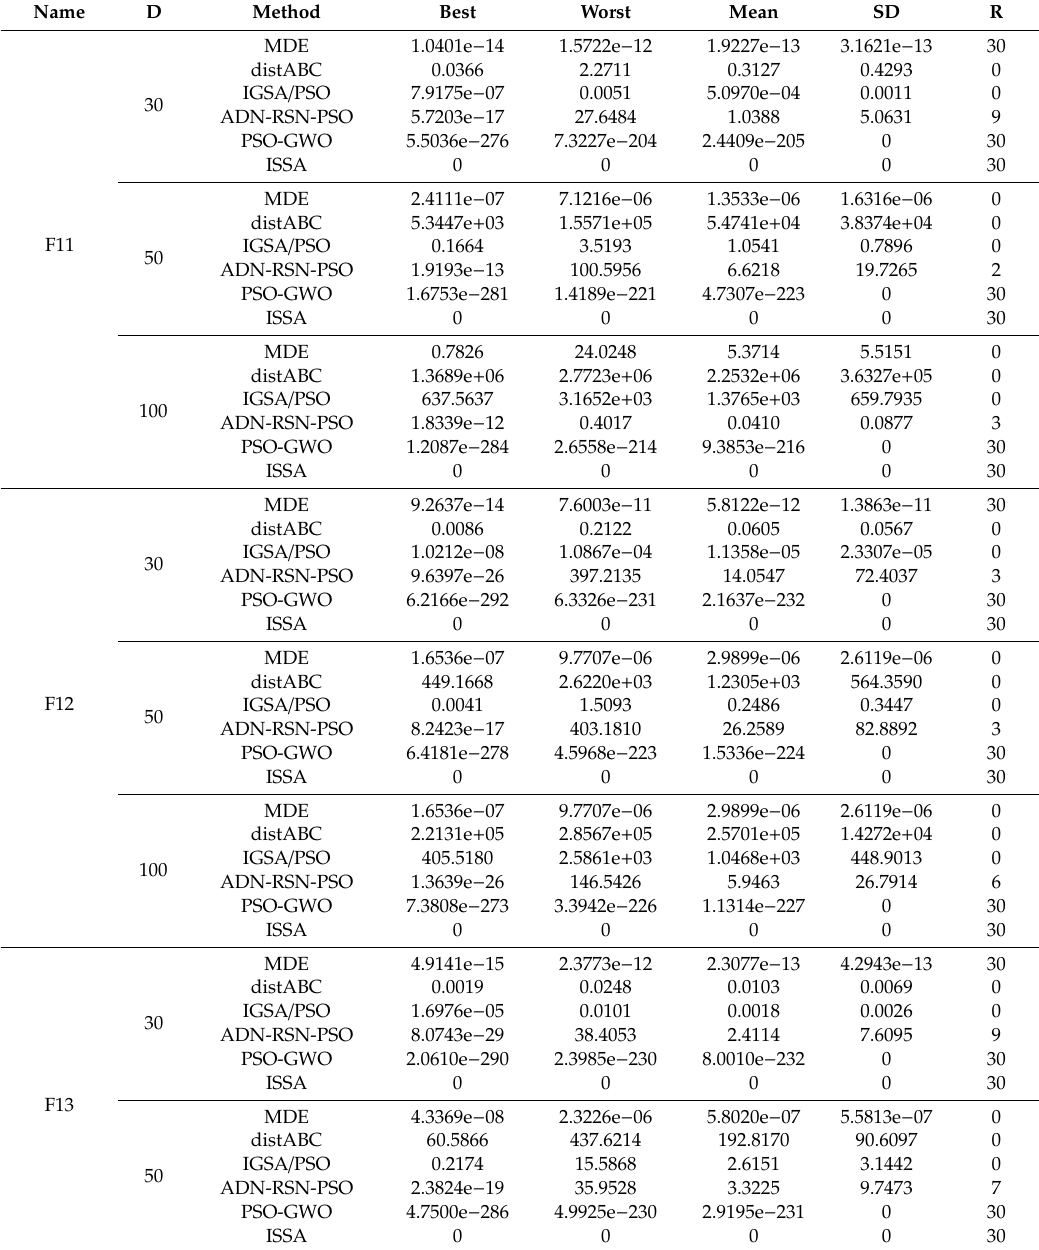
Table 11. The convergence results of